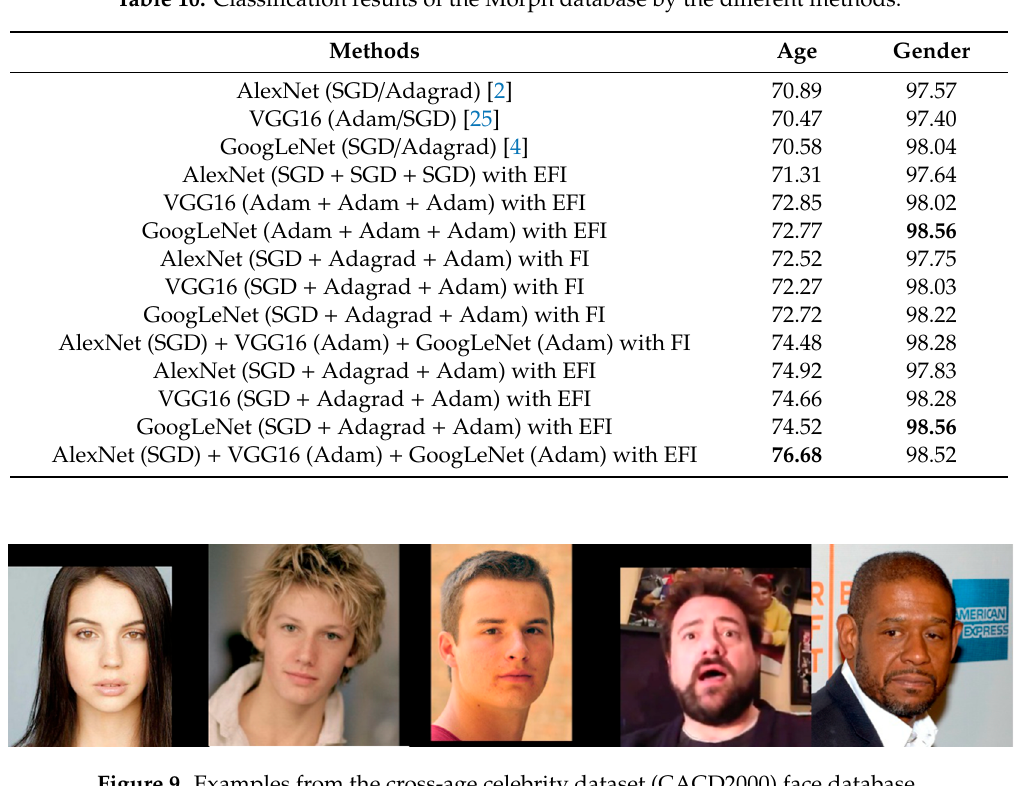
Table 10. Classification results of the Morph database by the di ff erent methods.